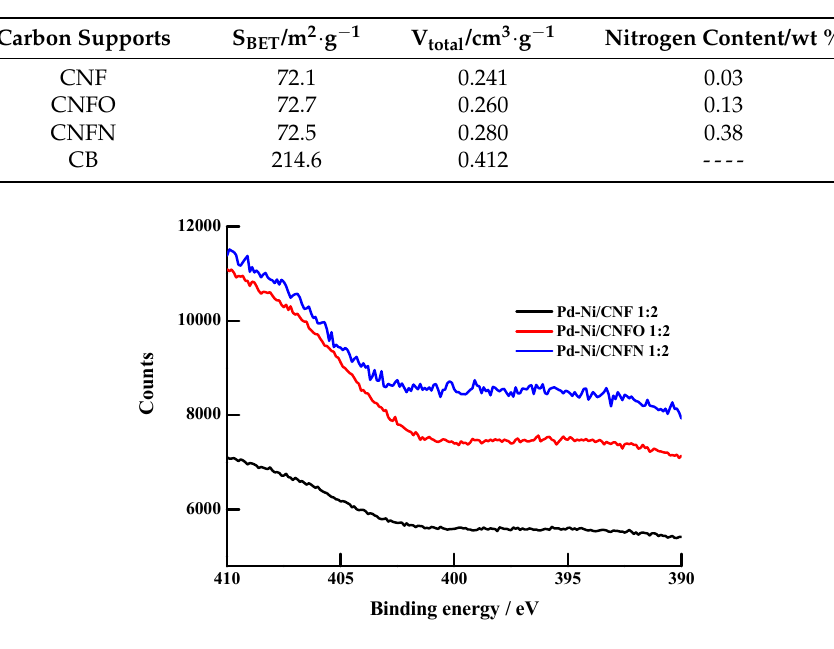
Figure 1. N 1 s X ‐ ray photoelectron spectroscopy (XPS) spectra for the synthesized Pd ‐ Ni catalysts supported on carbon nanofibers.